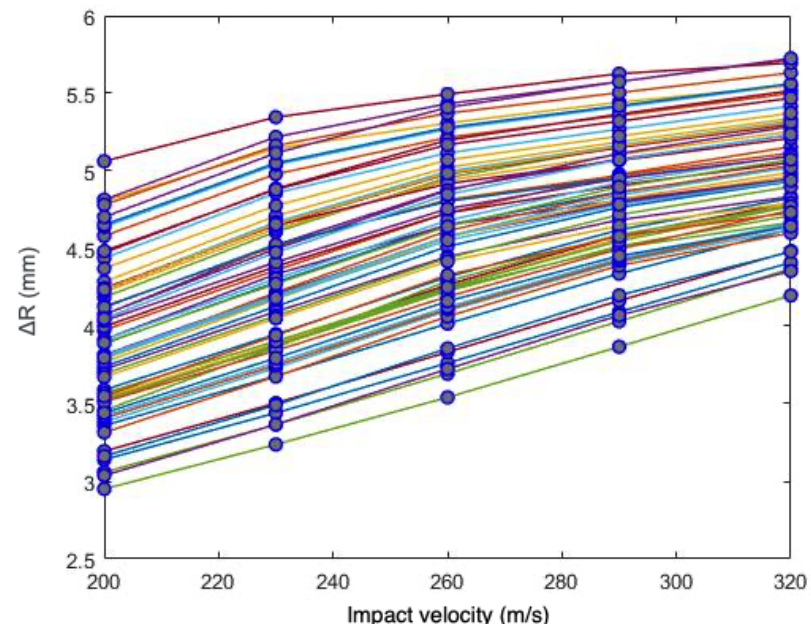
Figure 6. Linear interpolation of meta-model predictions of ∆ R for the Arrhenius-type constitutive relation.